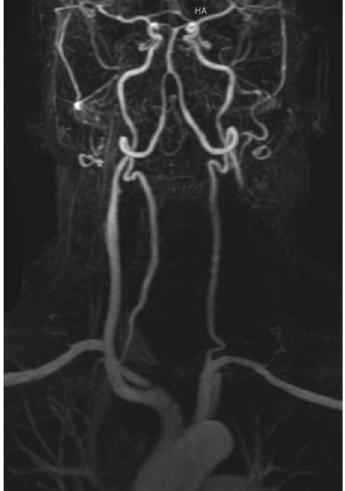
Figure 1: MRA postoperative day 2 demonstrates total occlusion of the left common carotid artery, including bifurcation and external carotid artery.